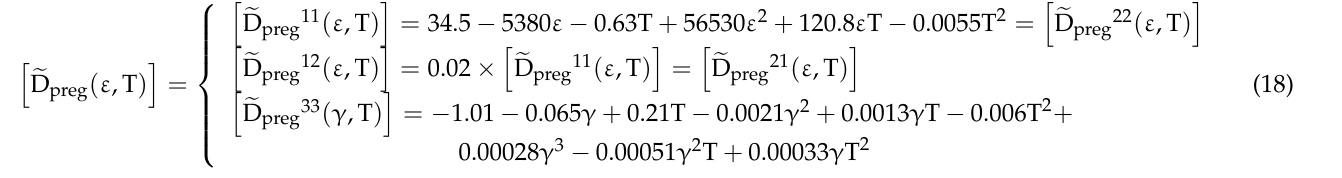
(cid:104) (cid:105) From Table 4, the R 2 parameters of the shear surface equation and axial (cid:101) D preg33 ( γ , T ) (cid:104) (cid:105) tensile surface equation are 0.980 and 0.997, respectively. Because the two (cid:101) D preg11 ( ε , T ) values are very close to 1, it also indicates that the surface equations have fully included the characteristics of the modulus curves. Besides, the traditional method only tests at one temperature and obtains the fixed elastic modulus of Equation (18). The